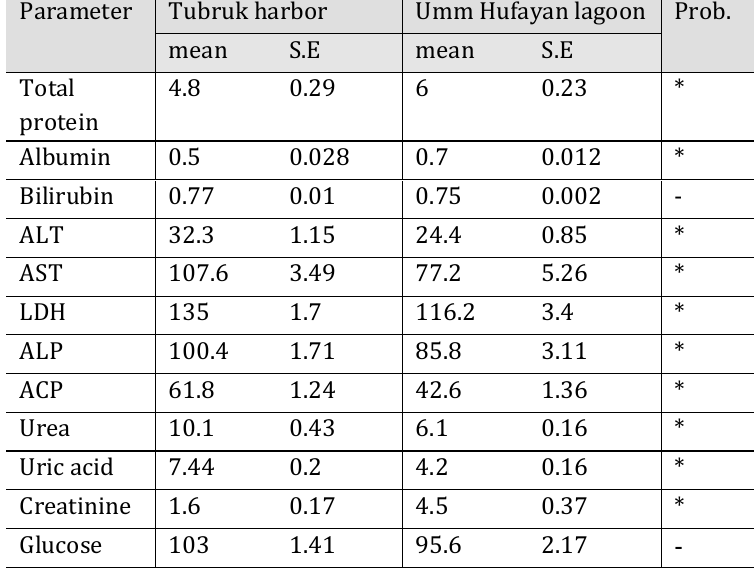
Levels of measured blood parameters mean (±